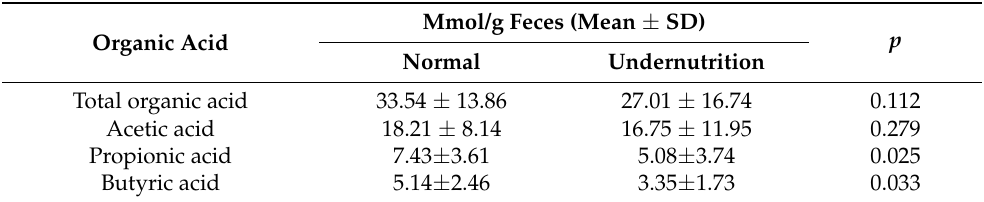
Table 3. Short Chain Fatty Acid Profile between the two groups.